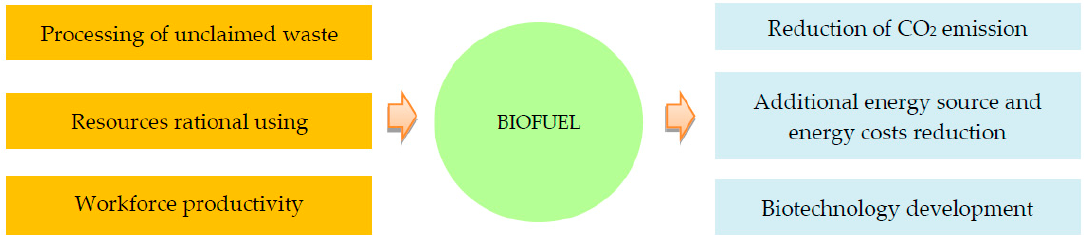
Figure 5. Scheme of organizational and economic approaches to use Biofuel production as a way to sustainable development in Russia regions [4,52,106,108,109].